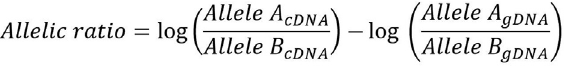
Figure 2 - Formula for calculating the log-transformed allelic ratio. The allelic ratio is the difference between the natural logarithm-transformed ratios of the allele heights of the cDNA and the